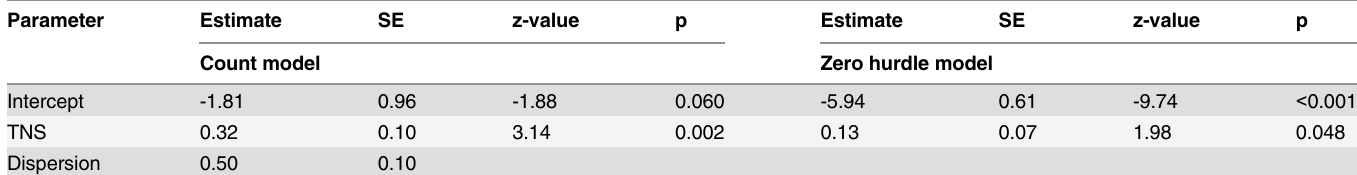
Table 3. Parameter estimates of the hurdle model for Aceria tosichella lineage MT-8 relating the observed abundance (truncated negative binomial distribution with log link) and prevalence (binomial distribution with logit link) to thermal niche suitability